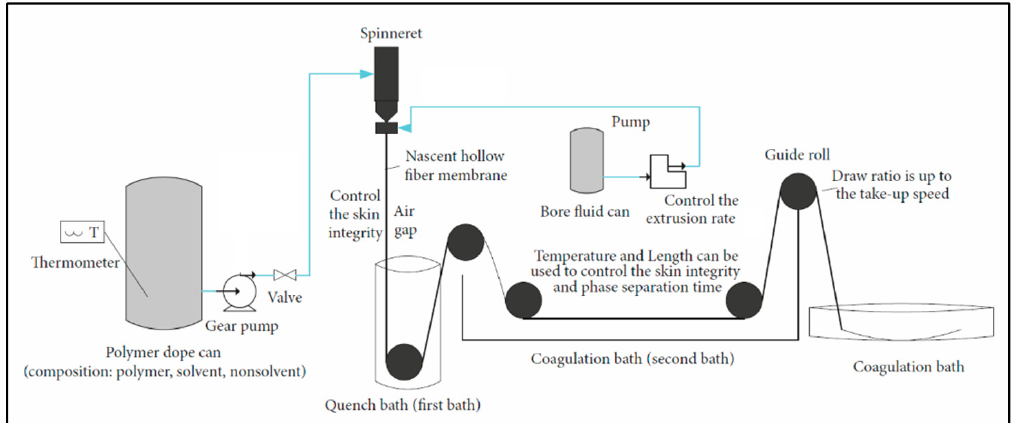
Figure 1. Schematic diagram of the hollow fiber spinning process.